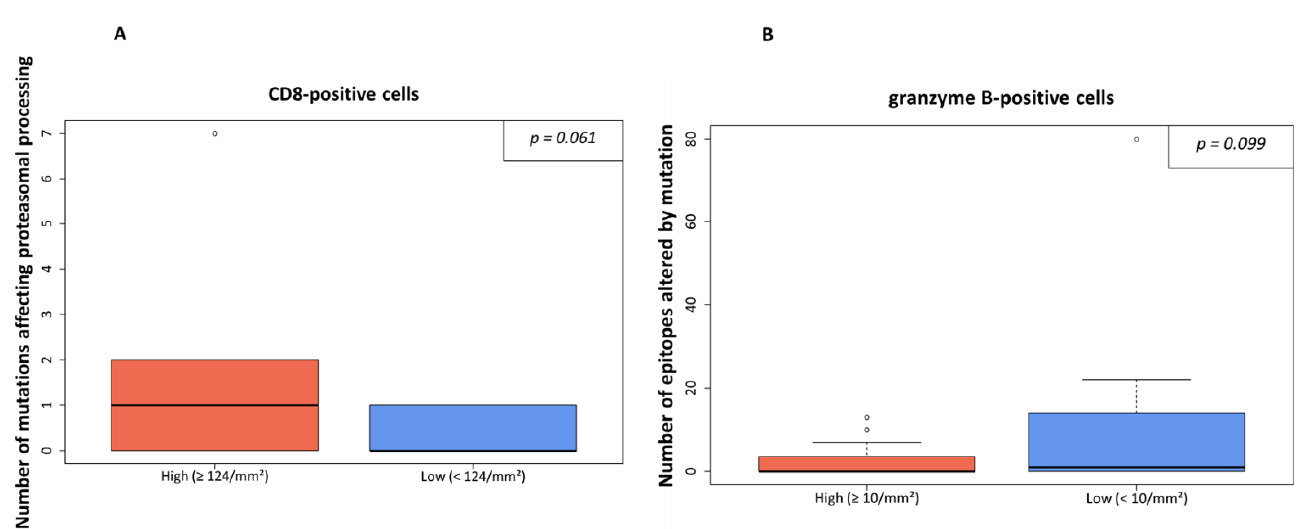
Figure 3. Processing escapes and CD8-/granzyme B-positive cell rate. In ( A ), the infiltration of CD8- positive cells is shown in relation to numbers of non-synonymous mutations influencing proteasomal processing. The amount infiltrating lymphocytes was either high ( ≥ 124/mm 2 ) or low (cutoff level: median value). In ( B ), the number of granzyme B-positive cells is shown in relation to the numbers of epitopes altered by mutation. The threshold was set at ≥ 10/mm 2 as indicated by the median value. The latter was also true in the case of the ratio of granzyme B- of all LCA-positive immune cells. In cases of a higher rate of mutations affecting proteasomal processing or a higher rate of epitopes affected by mutation, lower granzyme B/LCA-ratios were detected ( p = 0.048, Figure 4A, and p = 0.052, Figure 4B, respectively). However, the ratio of